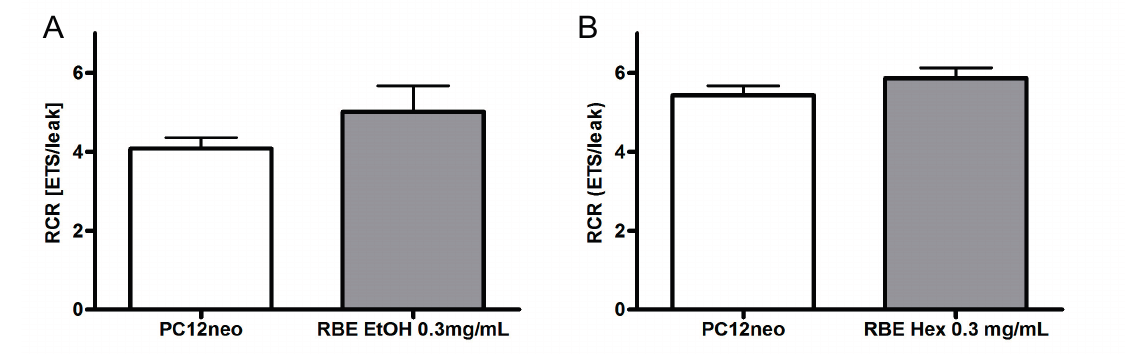
Figure 5. Respiratory control ratio (RCR) of PC12 cells after 24-h incubation with 0.3 mg/mL ethanolic (EtOH, ( A )) or hexanic (Hex, ( B )) rice bran extract (RBE) and the respective solvent control ethanol ( A ) or DMSO ( B ); respiration was measured using an Oxygraph-2k; RCR was calculated as ratio between uncoupled respiration and leak respiration after addition of oligomycin; n = 9–12; mean ± SEM; ANOVA with Tukey’s post- test. Citrate synthase (CS) activity is a common quantitative marker for the content of intact mitochondria [17]. CS activity was significantly increased in PC12 cells after a 24-h incubation with either ethanolic or hexanic RBE ( p < 0.05; Figure 6).